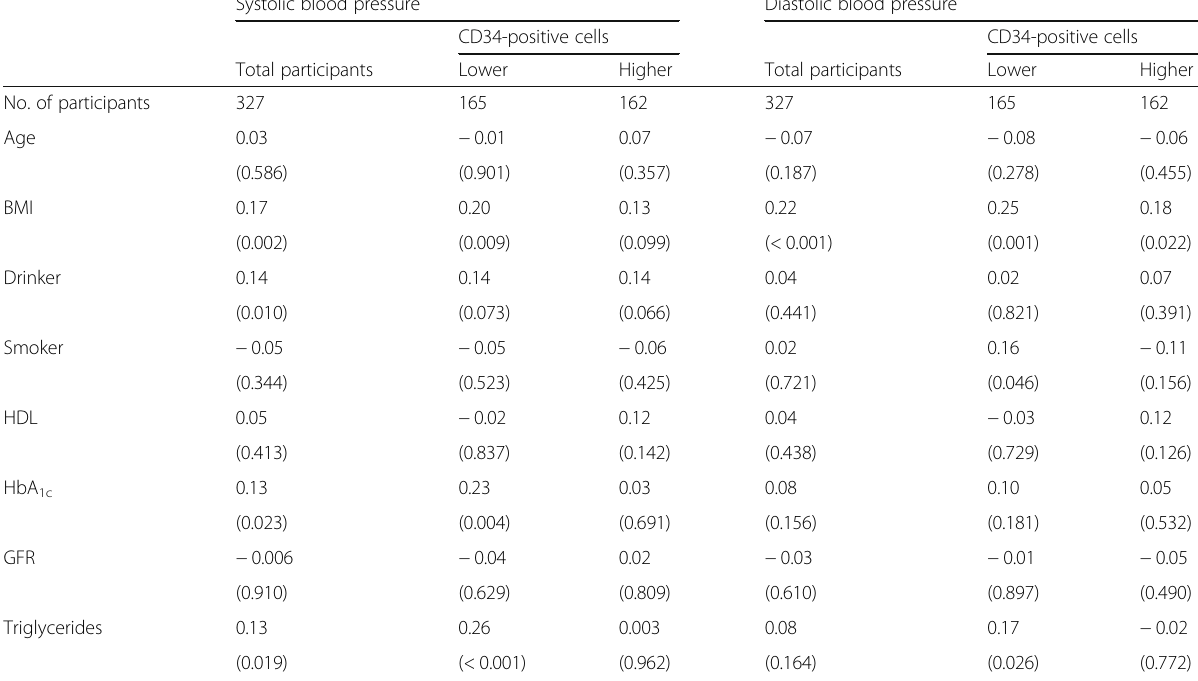
Table 2 Simple correlation coefficient of blood pressure (systolic and diastolic) and other variables